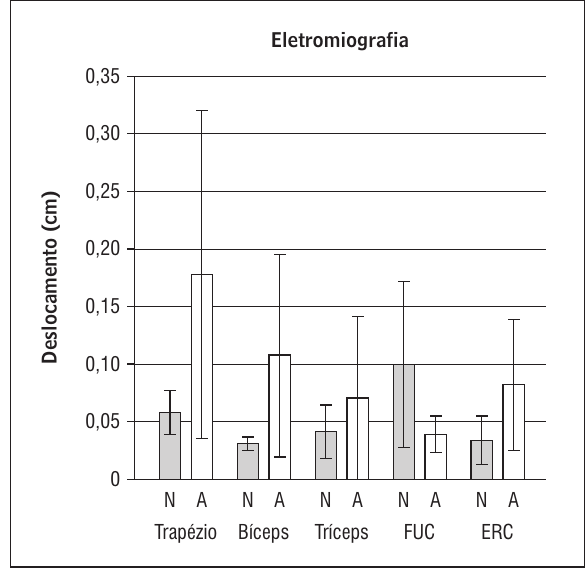
Gráfico 2 - Média e desvio-padrão do RMS normalizado para cada músculo dos lados não acometido e acometido Legenda: N = lado não acometido; A = lado